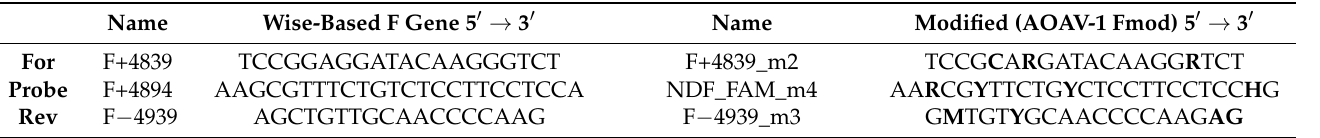
Figure 1. Primer and probe design. Alignment of the partial AOAV-1 F gene sequences (positions 296 to 396). Boldface: sequences corresponding to the primer and probe binding regions; grey shaded: nucleotides mismatching with the modified (AOAV-1 Fmod) primer/probe sequence; boldface underlined: nucleotides replaced compared to the Wise-based sequences; *: conserved nucleotides. Table 2. Primers and probes. Original Wise-based F gene and modified primers and probe for AOAV-1 F gene detection by